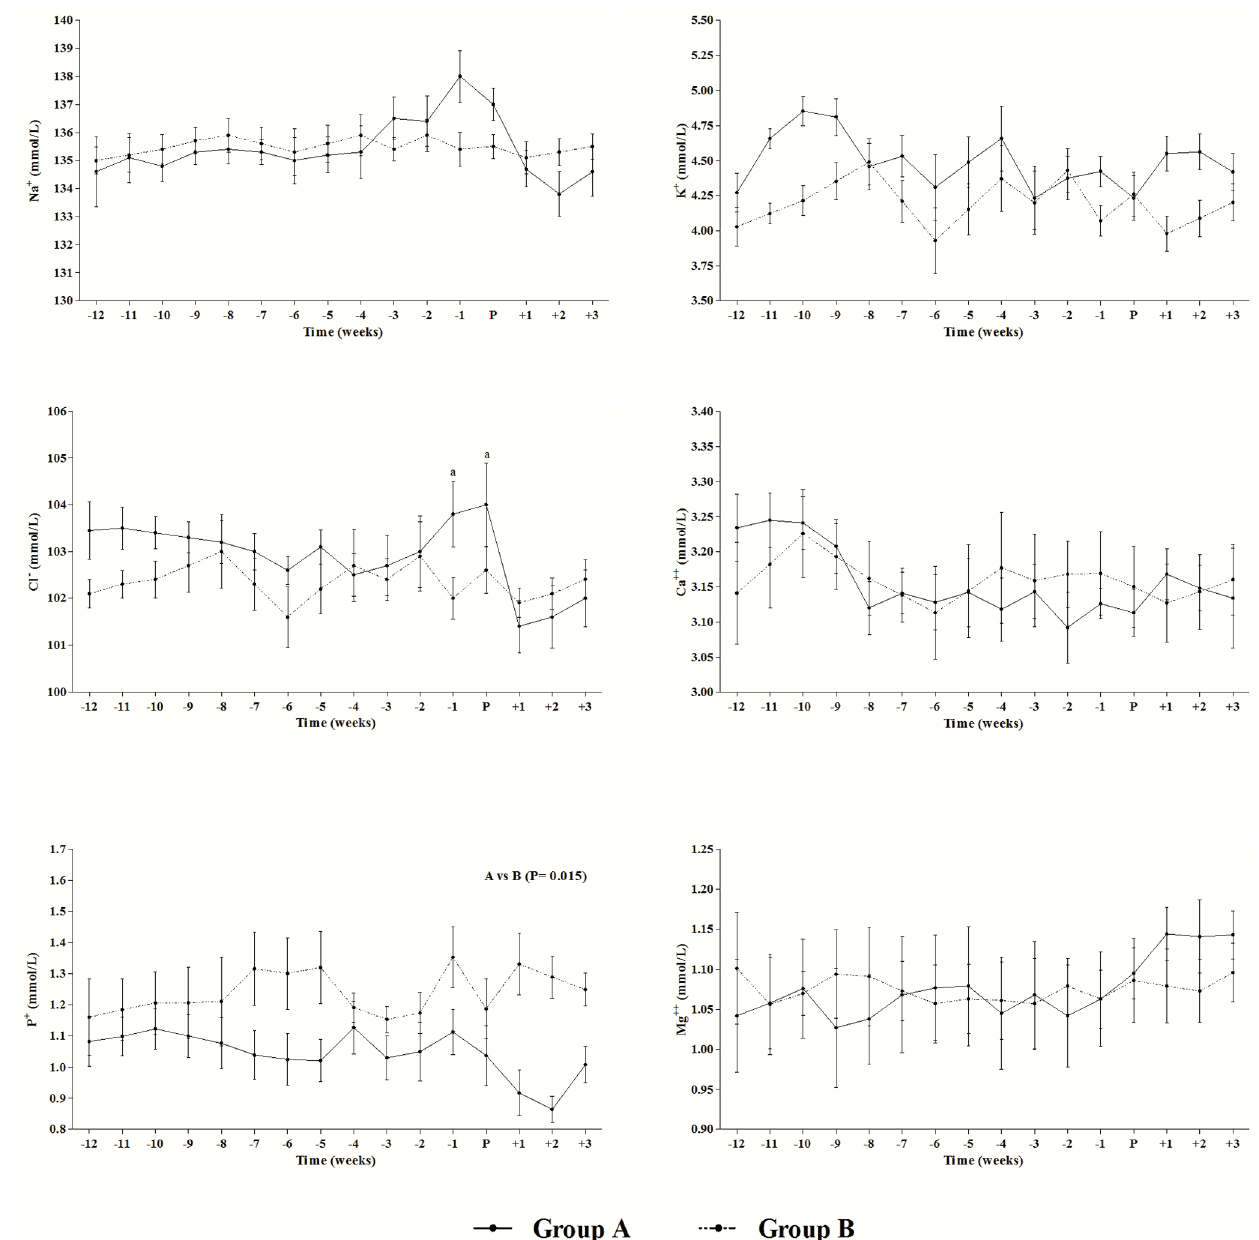
Figure 1. Means ± standard error of the mean (SEM) of Na + , K + , Cl − , Ca ++ , P + and Mg ++ obtained from pregnant (Group A) and control (Group B) mares. Time is expressed as weeks before ( − 12 to − 1) and after ( + 1 to + 3) parturition (P). Significance: “a” vs. + 1 and + 2 ( P< 0 .